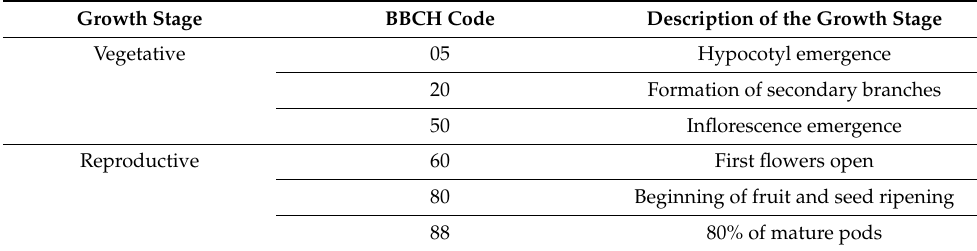
Figure 1. Monthly average values (blue), maximum (orange) and minimum (gray) temperature and relative humidity observed in the greenhouse during the test period.